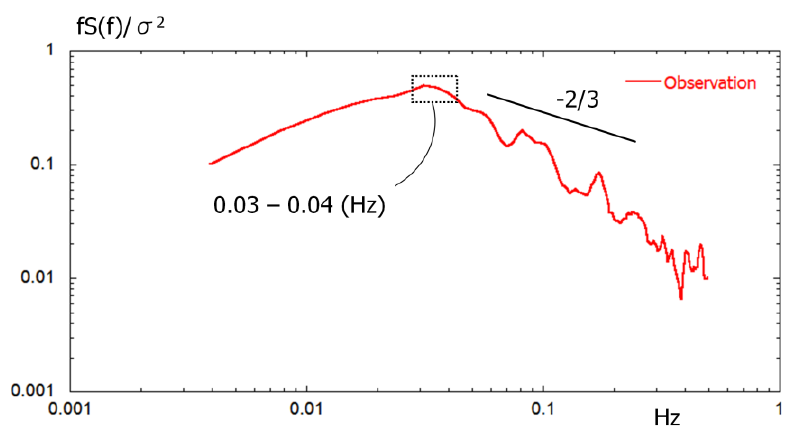
Figure 14. Power spectra of the observed data (red line) from Figure 13.